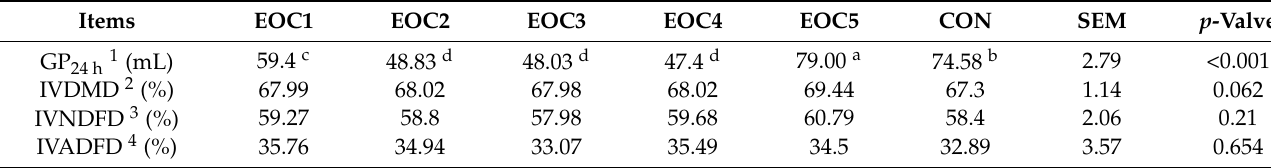
Table 2. Effects of EOC on gas production parameters.